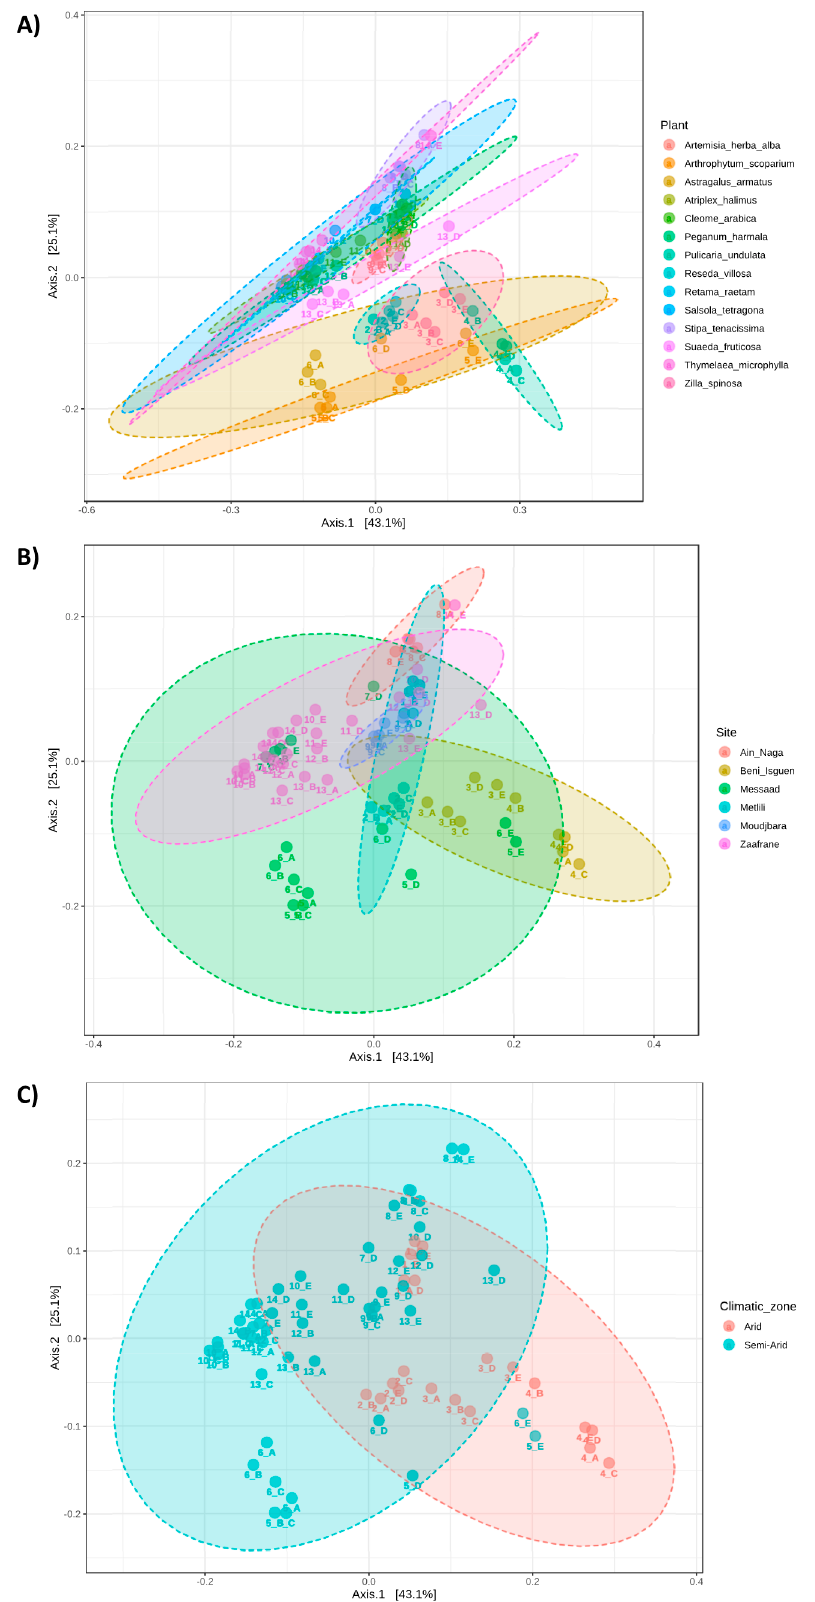
Figure 3. Beta diversity analysis at species level. Principal Coordinate Analysis (PCoA) based on Bray–Curtis metrics shows the dissimilarity of bacterial communities in the different soils according to ( A ) plant species ( p -value < 0.001), ( B ) sampling site ( p -value < 0.001), ( C ) and climatic zone ( p -value < 0.001). Beta diversity analysis was performed using MicrobiomeAnalyst.